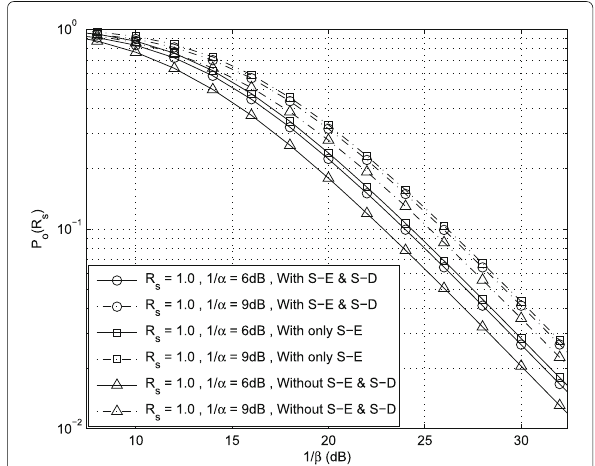
Fig. 3 Comparison of outage probability under three scenarios: (1) with direct link between both S − D and S − E , (2) with direct link only between S and E , and (3) with no direct link between both S − D and S − E for 1 /α = 6 and 9 dB, R s = 1.0, and γ th = 3 dB of single balanced relay system